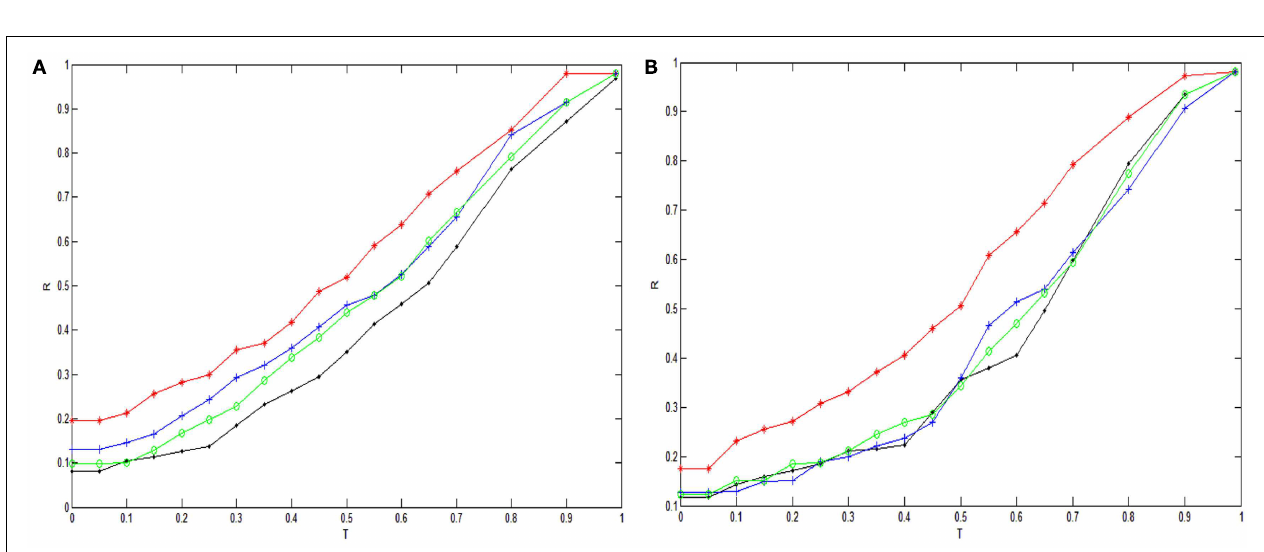
every stage of experiment group (black, blue, and green curves) in all values of threshold. The cumulative probability of size-ratio of cascading failure P ( d (cid:48) ≥ d ) is plotted versus the size of cascading failure of node d in Figure 3 (glioma) and Figure 4 (renal